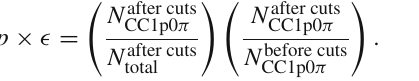
planes (U and V) and in the collection plane (Y). In a CC1 p 0 π event, R Δ Q is expected to be close to unity for a box with dimensions that do not encapsulate too much noise from non-neutrino induced